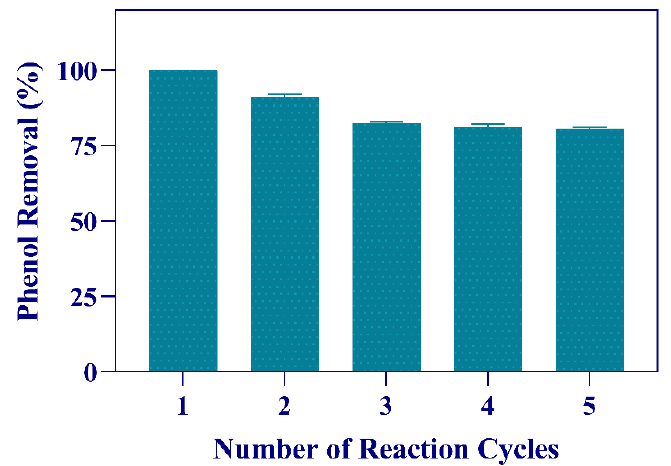
Figure 6. Reusability of immobilized Sphe3 cells for phenol removal. The activity of the first cycle was considered as 100%. Each reaction cycle was carried out for 48 h. Error bars indicate standard deviation of three measurements.